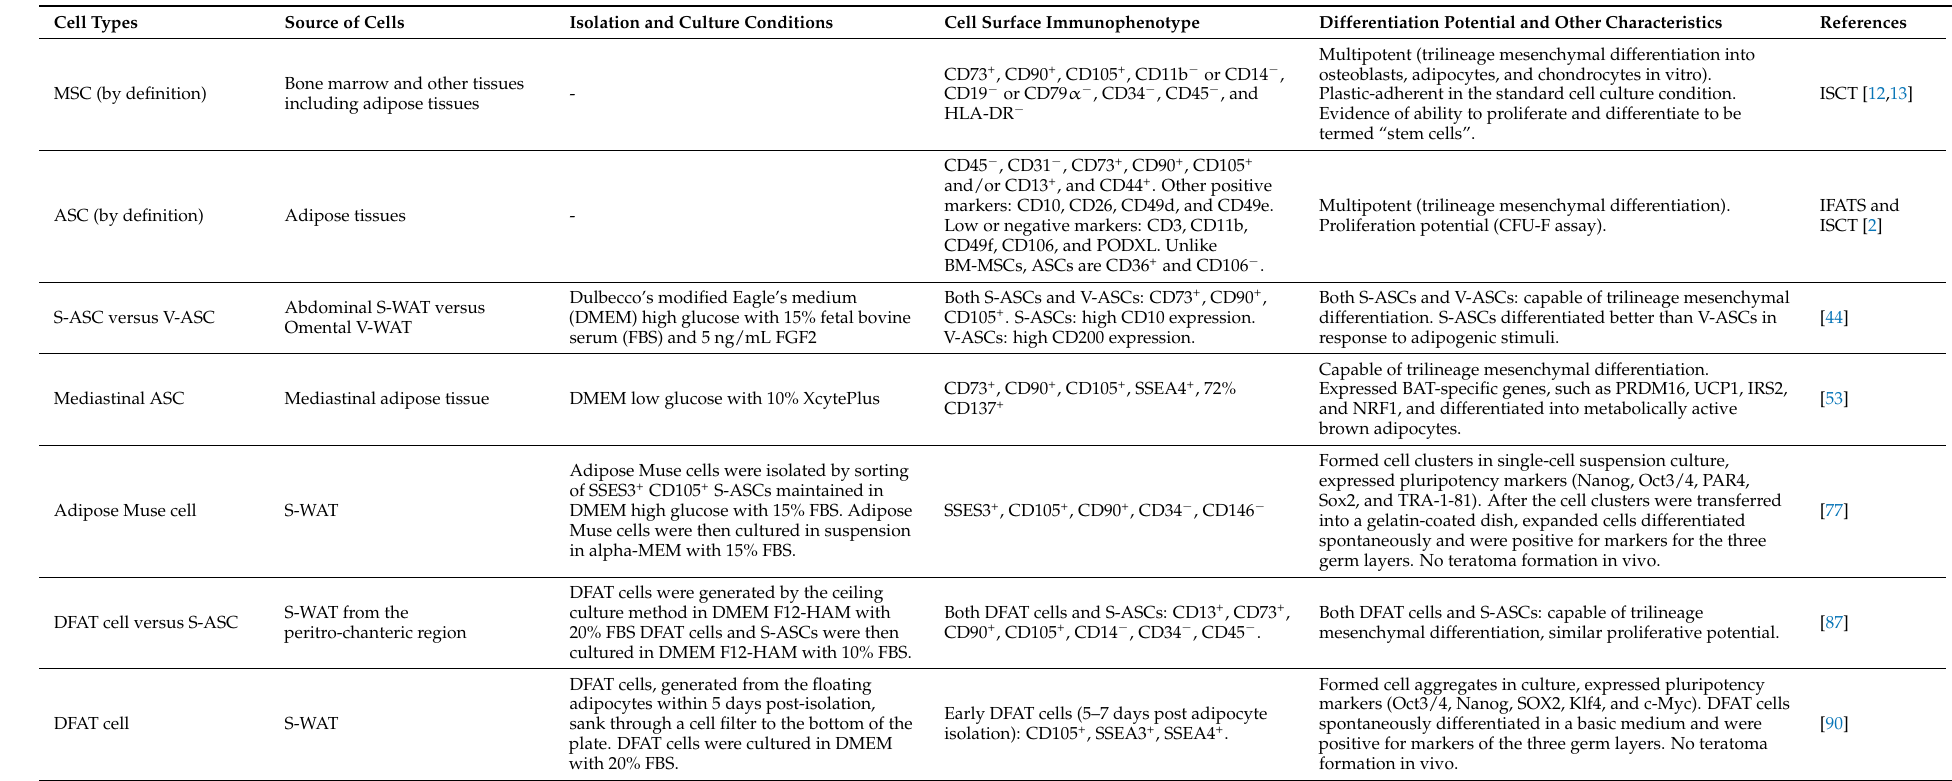
Table 1. Characteristics of cultured adipose-derived cells from representative